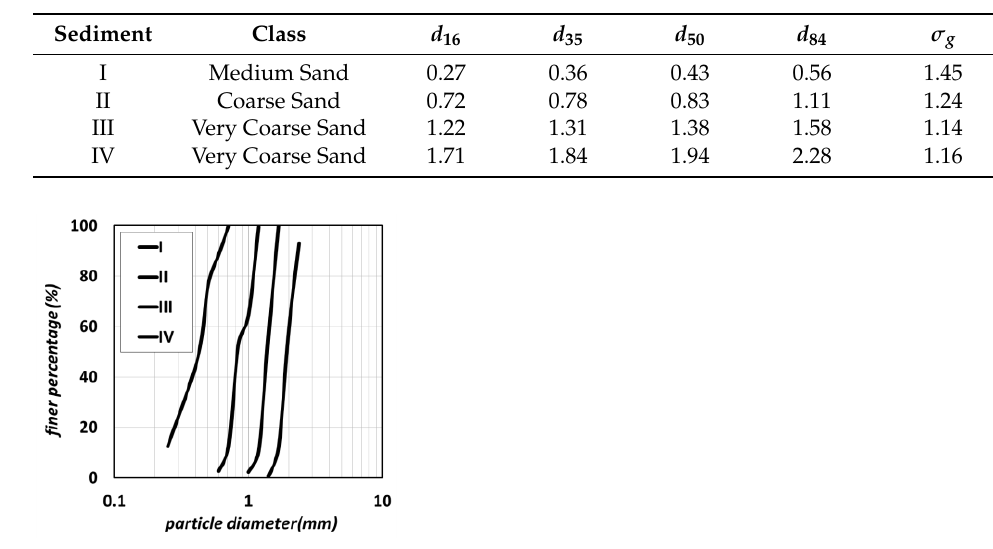
Figure 2. Gradation curves of sediment particles (from left to right are I, II, III, and IV, respec-